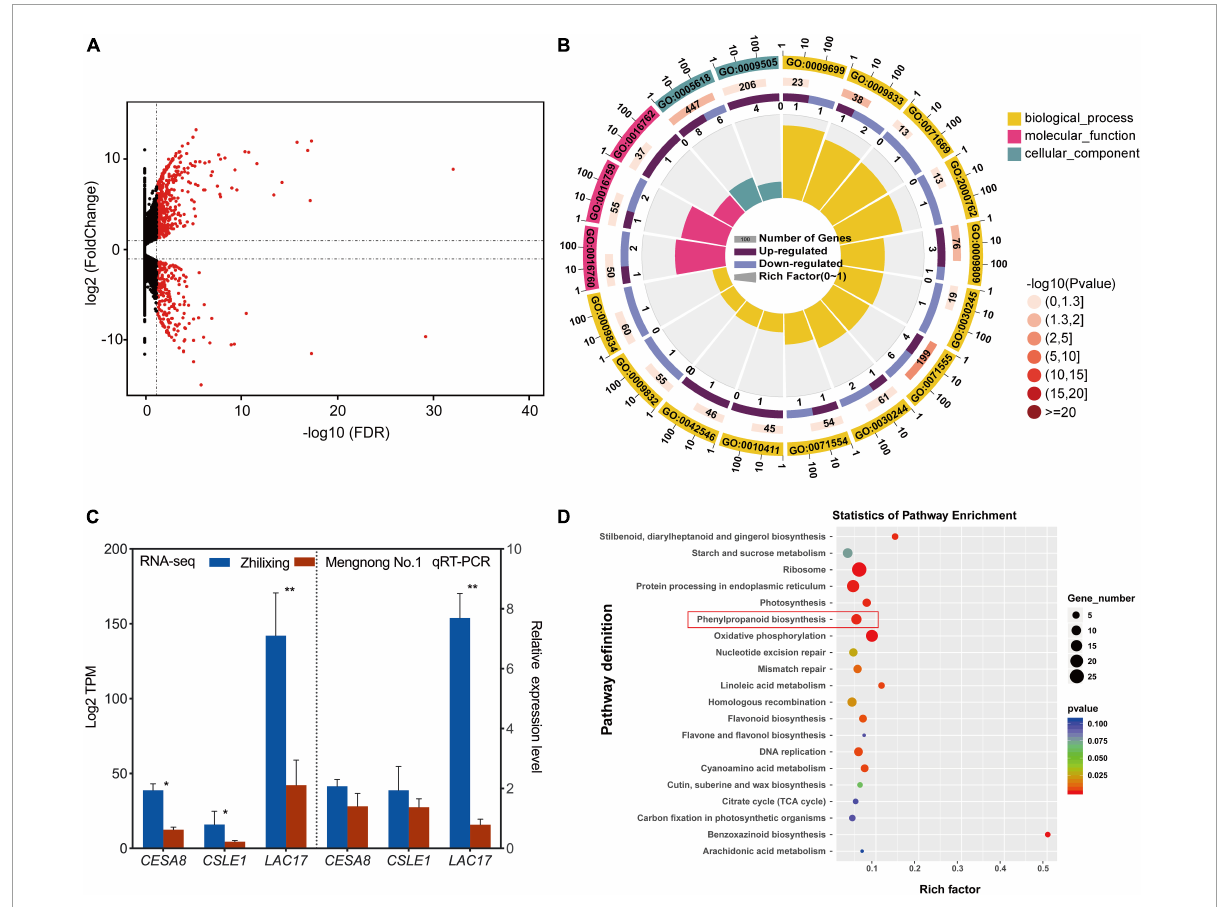
FIGURE3 Differential expression of cell wall related genes in the M. ruthenica cultivars Zhilixing and Mengnong No.1. (A) MA plot (M-vs.-A plot) showing the relative expression level of all unigenes between the two cultivars. Red and black dots represent differentially expressed genes and genes with no significant expression difference, respectively. (B) GO categories associated with cell wall-related biogenesis. The outer circle presents the classification of enrichment, “1, 10, 100” is the coordinate ruler of the number of genes. The second circle (outside-to-inside, similarly hereinafter) gives the number of this classification in the background gene and the Q -value or P -value. The third circle is a bar chart showing the proportion of up-regulated DEGs and down-regulated DEGs (Mengnong No.1 vs. Zhilixing), and the specific values are shown below. The fourth circle gives a richness factor value of each classification (the number of DEGs divided by the number of background genes in the classification). (C) Expression of cell wall-related unigenes of the two M. ruthenica cultivars by RNA-Seq and qRT-PCR analysis. The expression level in Mengnong No.1 was set to 1. MrActin was used as the internal control. Values are means ± S.D. of three biological replicates. Asterisks indicate significant differences determined by Student’s t -tests (** p < 0.01, * P < 0.05). (D) KEGG enrichment analysis with the